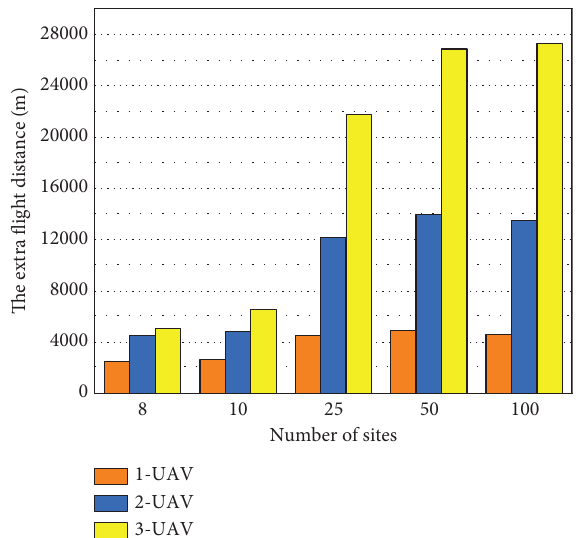
Figure 15: UAV extra fight